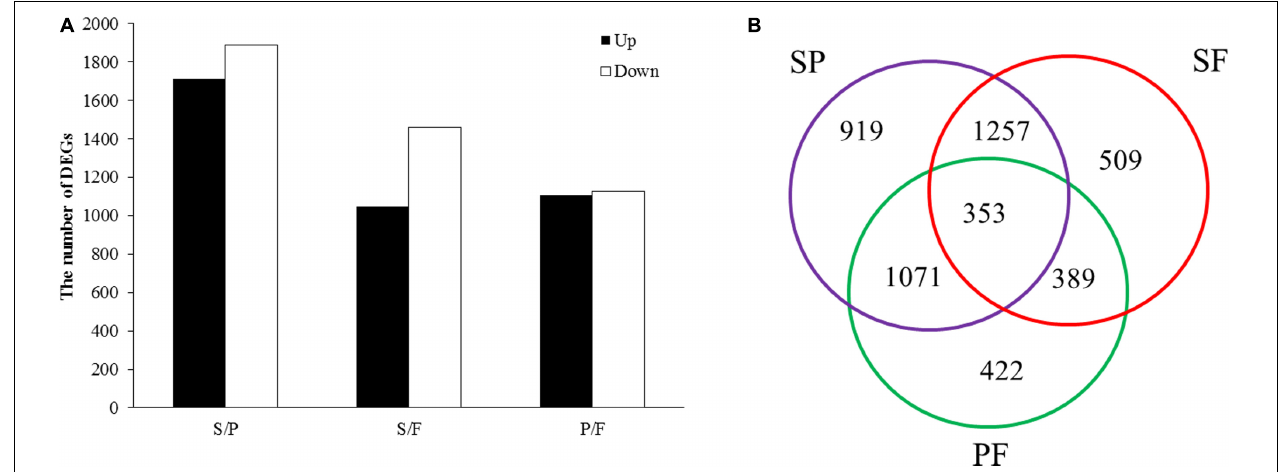
FIGURE 2 | Analysis of DEGs between different developmental stages. (A) DEG distribution between two analyzed samples. The number of differentially expressed genes is indicated at the top of the histograms. (B) Venn diagrams comparing shared DEGs between the adjacent growth